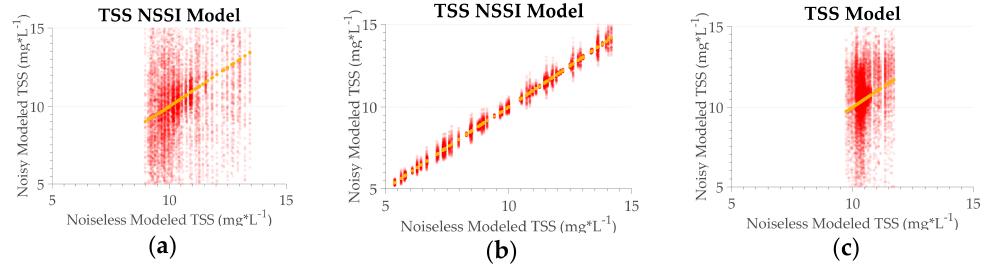
Figure 10. TSS_NSSI algorithm performance for TSS concentration. ( a ) MSI sensor; ( b ) OLCI sensor; ( c ) OLI sensor. Circles in red represent the data with noise, circles in yellow noiseless data. The transparency is based on the frequency distribution, in which opaque indicates a higher frequency, and transparent indicates a lower frequency.